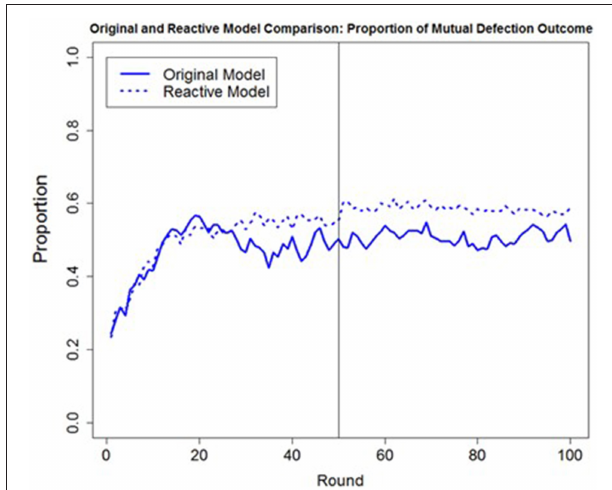
FIGURE 11 | The overall round-by-round proportion of mutual defection in the original trust model (solid blue line) that used both the trust and trust invest accumulator and the reactive model (dashed blue line) that used only the trust accumulator during a simulation of 16 different conditions where the confederate agent changed its strategy after the first game, changing from the Pavlov-Tit-for-Tat (PT4T) to the Tit-for-Tat (T4T) strategy or from the T4T to the PT4T strategy.